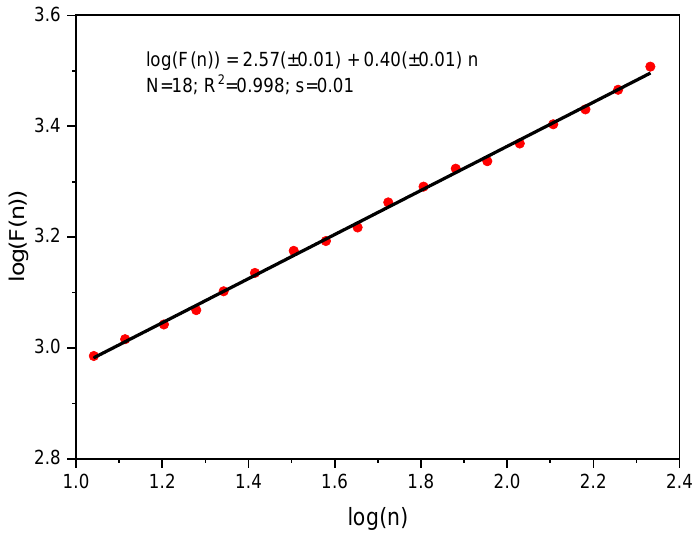
Figure 3. Function F(n) vs. block size n for graphite G1.